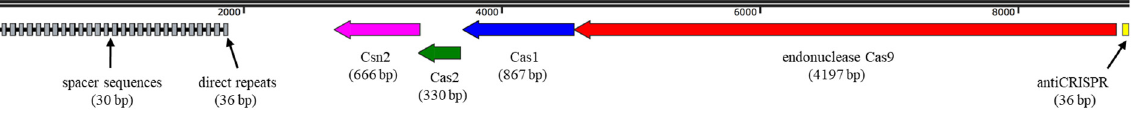
Figure 4. Schematic representation of the CRISPR ‑ Cas9 (Type II ‑ A) array system identified in the Streptococcus lutetiensis UFV80 genome. The arrows indicate the direction of transcription for each gene. The entire array sequence covered a region of 8850 bp in the bacterial genome.